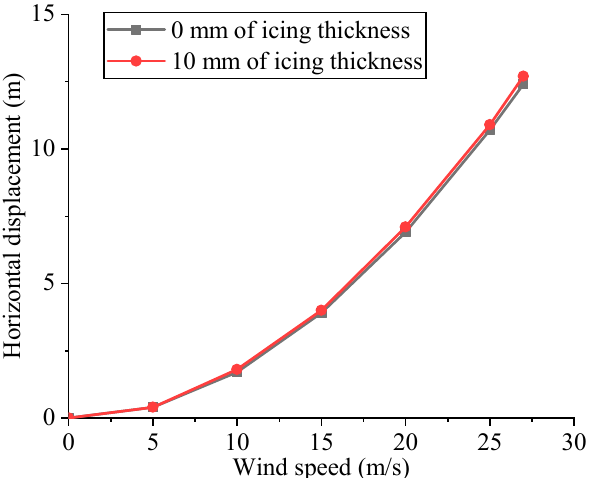
Figure 16. The influence of wind speed on maximum horizontal displacement of conductor.